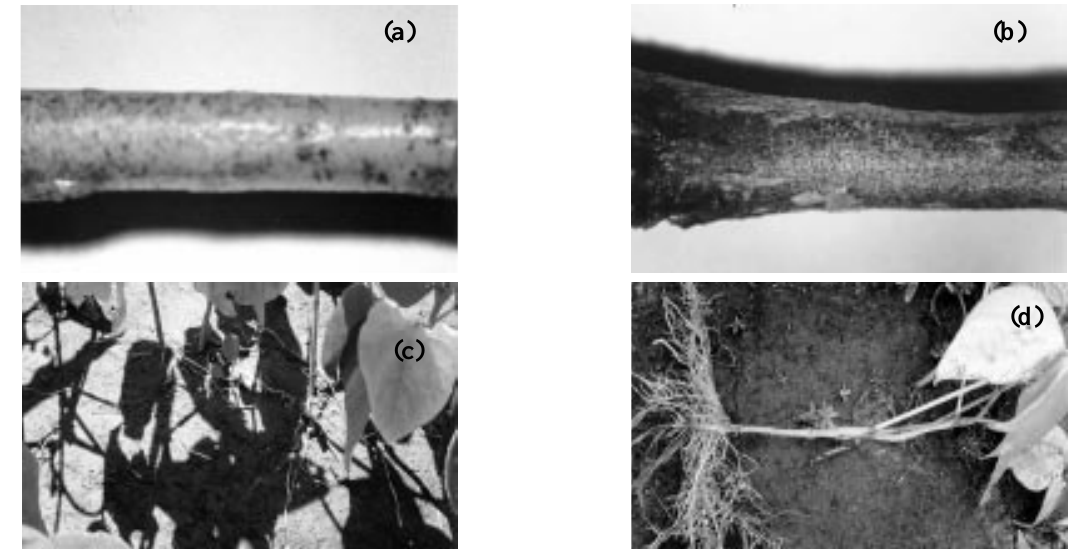
Figura 5. Formação de lenticelas na base do caule no T lençol (b); desenvolvimento de raízes adventícias junto à superfície do solo (c e d).